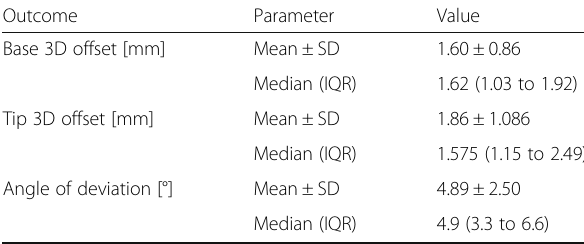
Table 2 Descriptive statistics for the different outcomes of